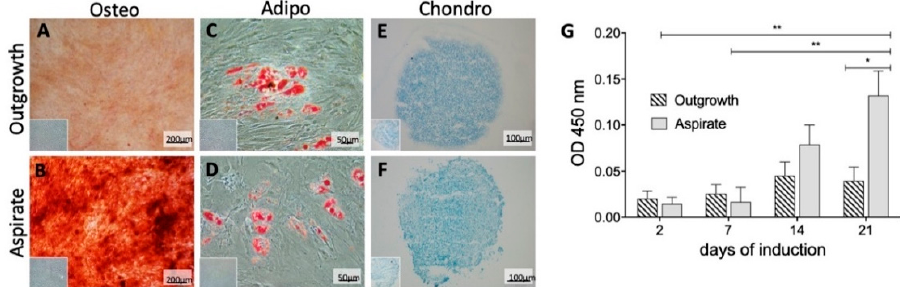
Figure 5. Di ff erentiation capacity of MSCs from outgrowth and aspirate cultures. ( A , B ) Alizarin Red S, a staining for mineral deposits, indicates an osteogenic di ff erentiation. Aspirate cells showed an increased signal compared to outgrowth cells. ( C , D ) Oil Red O is an indicator for lipids and visualizes adipocytes in red. Both niches were able to di ff erentiate without significant di ff erence. ( E , F ) Cell pellets with cartilaginous di ff erentiation that were cut into 12 µ m cryosections. Samples were subsequently stained with Alcian Blue to detect acid mucoids. Controls are indicated in the bottom left corners and in Supplementary Figure S2. ( G ) For quantification of the increased osseous di ff erentiation potential of the aspirate cultures, the OD was measured at 450 nm at the indicated time points of osteogenic